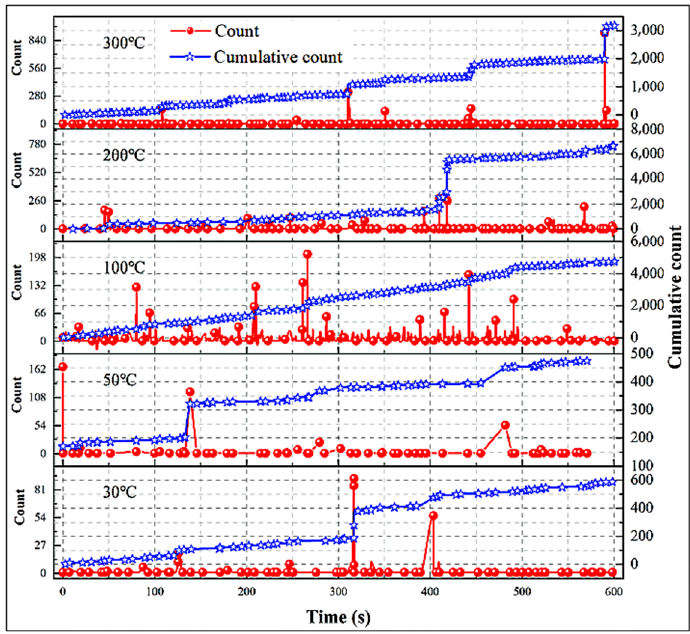
Figure 4. 600 s AE count of different temperature stages in the spontaneous combustion process of coal.